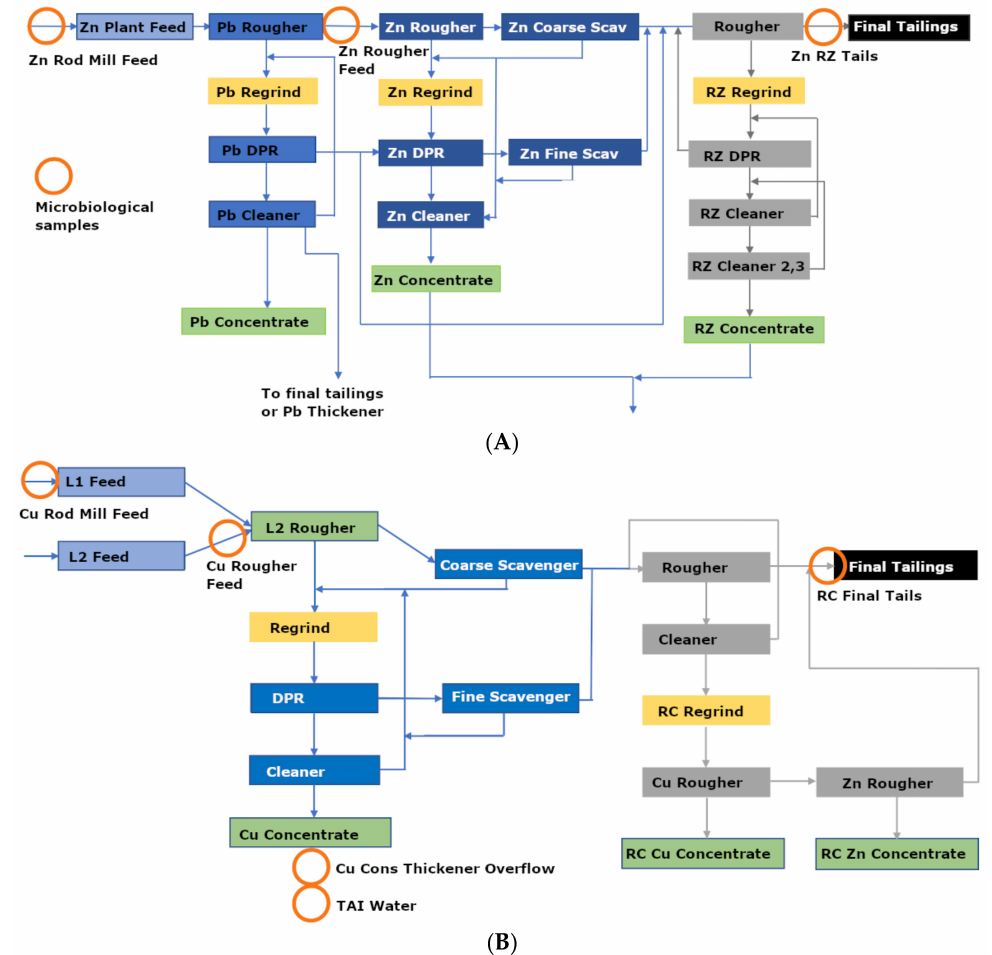
Figure 1. A schematic simplified representation of the zinc ( A ) and copper ( B ) process plants and microbial sampling points (orange circles). Additionally, microbial samples were taken from mine water treatment plant (ETAM) In and Out flows, Paste Thickener Overflow and the raw water source Santa Clara